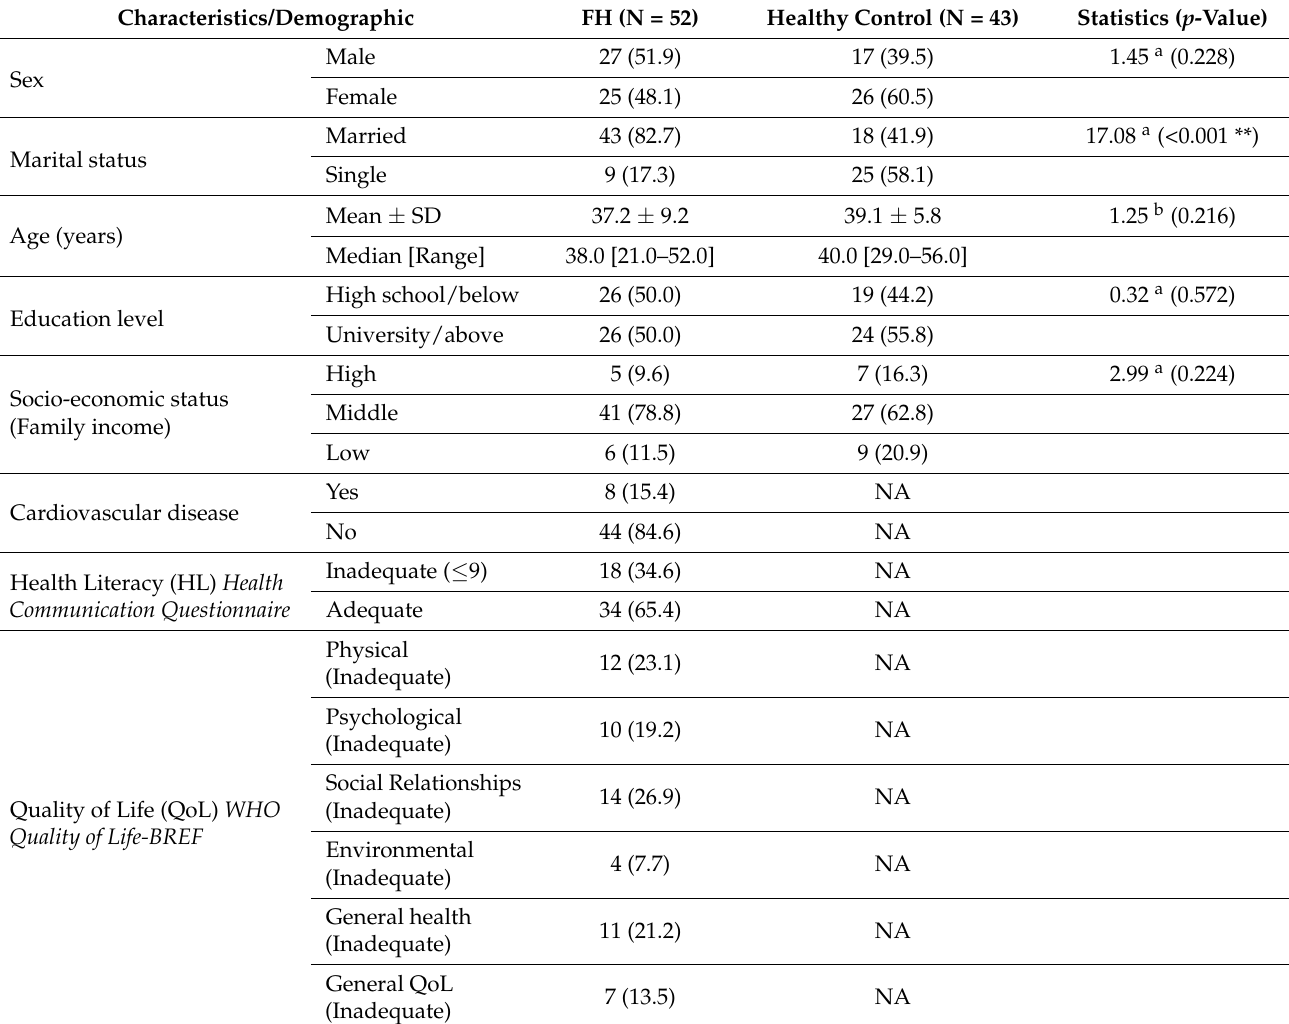
Table 1. Characteristics of the study